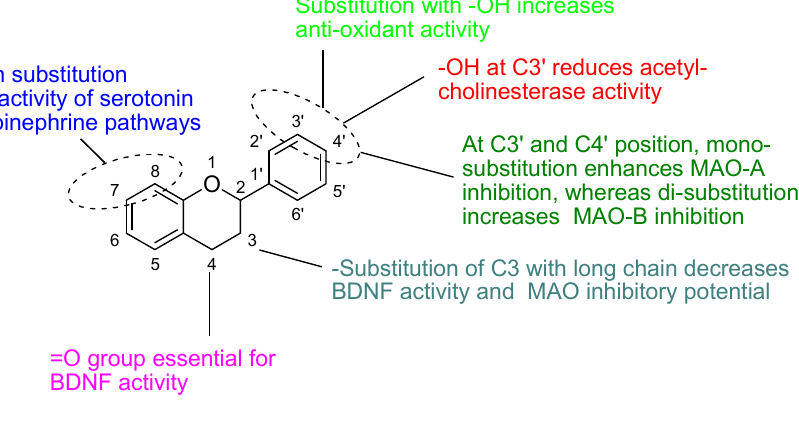
Figure 53. SAR of Flavonoids.